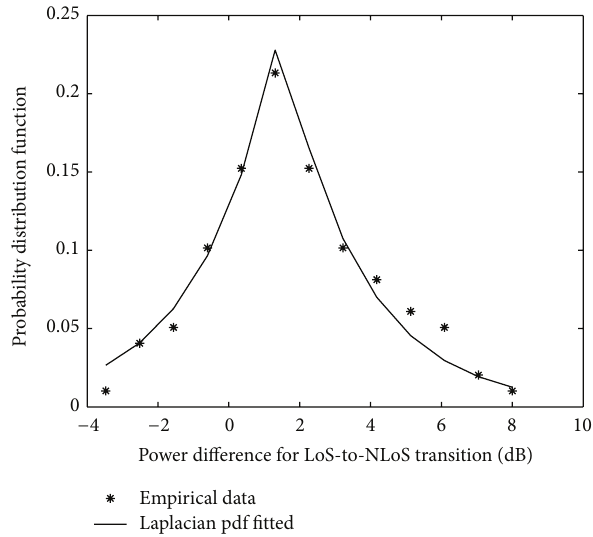
Figure 15: The empirical pdf and fitted Laplacian pdf for the power difference of the channels before and after the LoS-to-NLoS transition.